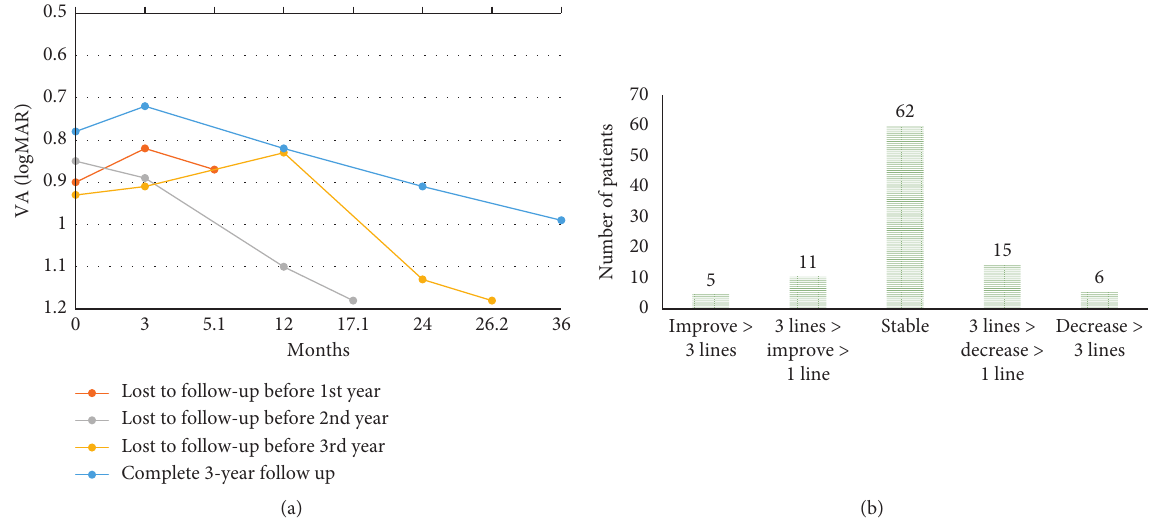
Figure 1: (a) Visual outcome at month 3, year 1, year 2, and year 3 in lost-to-follow-up before year 1, year 2, and year 3 and complete 3-year follow-up groups. (b) The third-year visual outcome compared to baseline in the complete 3-year follow-up